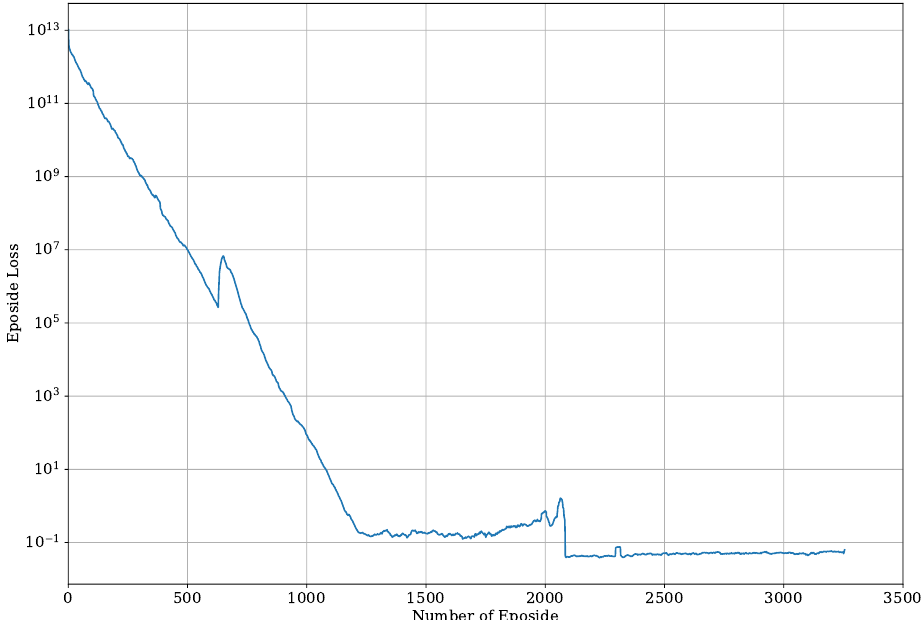
Figure 9. Loss values for the DQN